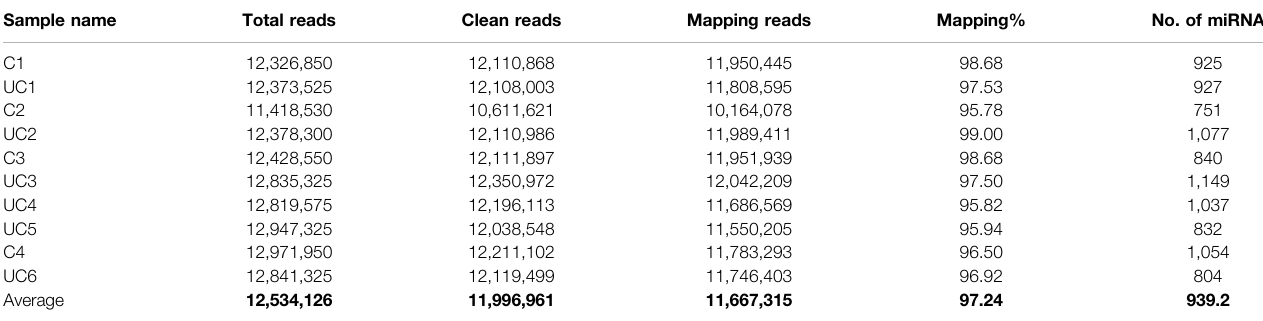
TABLE 1 | Read counts and known miRNA numbers detected in all 10 samples. Average of each